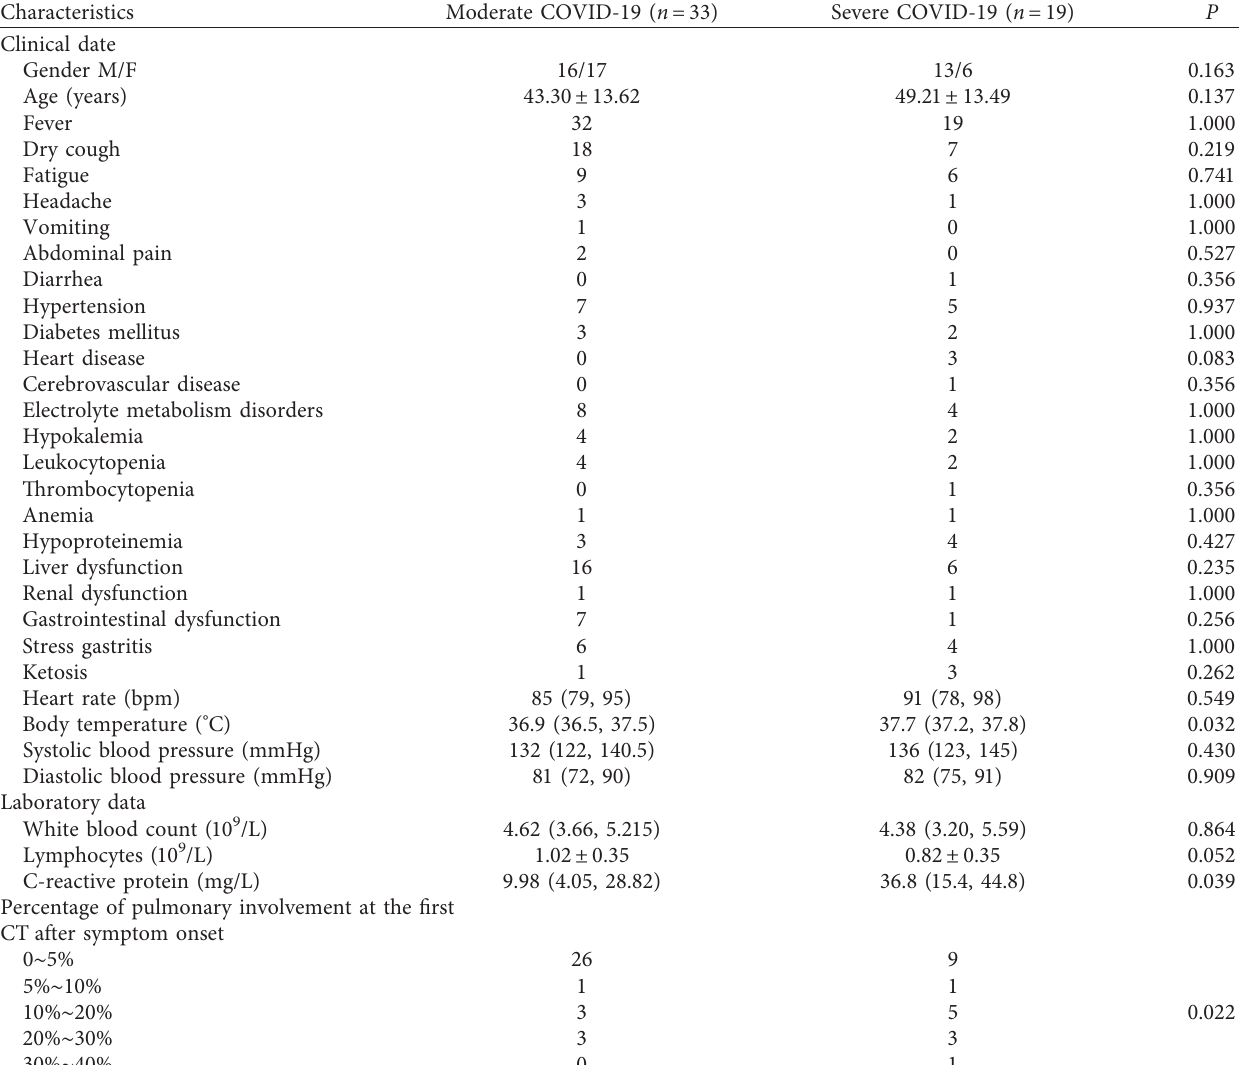
Table 1: Characteristics of 52 patients with COVID-19 after symptom